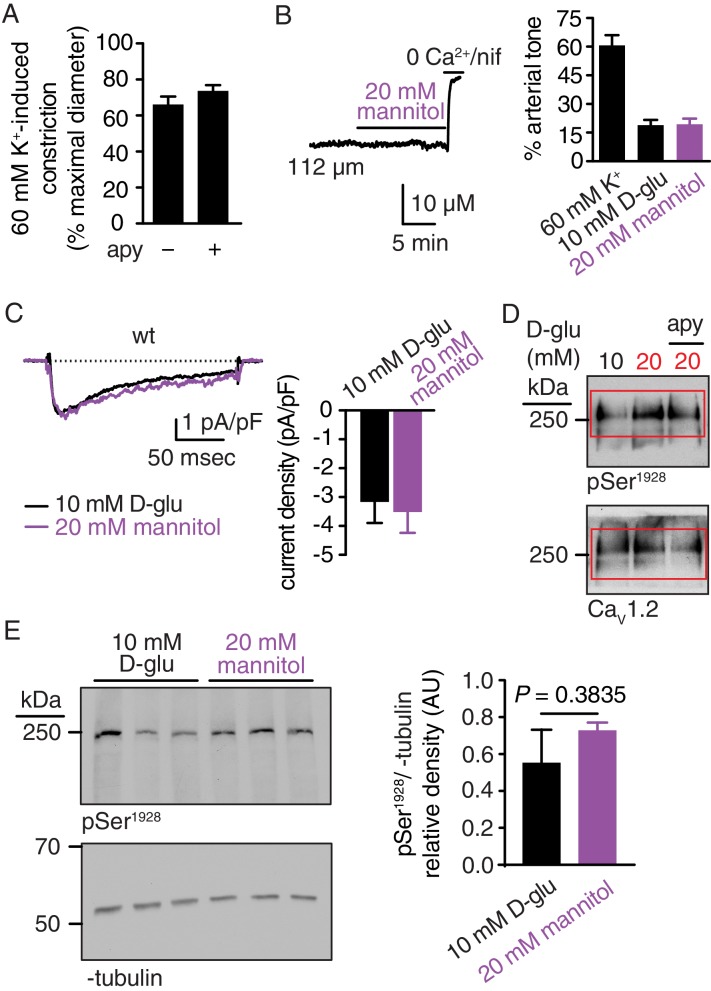
K+-induced arterial constriction in the absence and presence of apyrase, no changes in arterial tone, IBa and pSer1928 in response to 20 mM mannitol, and full-length blots corresponding to Figure 1C.(A) Bar plot of % constriction in response to high K+ (60 mM) from wt mouse cerebral arteries exposed to 10 mM D-glucose in the absence and presence of apyrase (apy; 0.32 U/ml; n = 6 arteries from six mice per condition; Figure 1—figure supplement 1—source data 1). Response to high K+ (60 mM) was obtained in pressurized arteries at 20 mmHg. (B) Representative diameter recording and summary arterial tone data from pressurized (60 mmHg) wt mouse cerebral arteries before and after application of 20 mM mannitol (n = 6 arteries from six mice; Figure 1—figure supplement 1—source data 2). (C) Exemplary IBa recording from the same cell and summary IBa data from wt mouse cerebral arterial myocytes evoked by step depolarizations from −70 to +10 mV before and after application of 20 mM mannitol (n = 7 cells from three mice; Figure 1—figure supplement 1—source data 3). (D) Complete scan of representative phosphorylated Ser1928 (pSer1928) and total CaV1.2 blots for mouse arteries incubated with 10 mM D-glucose, 20 mM D-glucose and 20 mM D-glucose +apyrase. Red boxes indicate the crop region displayed in the main Figure 1C. (E) Representative immunoblot detection of phosphorylated Ser1928 (pSer1928) and α-tubulin (loading control) from wt mouse arteries after 10 min incubation in either 10 mM D-glucose or 20 mM mannitol (n = 5 arterial lysates from five mice per condition) and quantification of pSer1928 (AU = arbitrary units) (*p=0.3835, unpaired t-test; Figure 1—figure supplement 1—source data 4).10.7554/eLife.42214.004Figure 1—figure supplement 1—source data 1.Excel spreadsheet containing the individual numeric values of 60 mM K+-induced % constriction analyzed in Figure 1—figure supplement 1A.10.7554/eLife.42214.005Figure 1—figure supplement 1—source data 2.Excel spreadsheet containing the individual numeric values of % arterial tone analyzed in Figure 1—figure supplement 1B and corresponding raw diameters.10.7554/eLife.42214.006Figure 1—figure supplement 1—source data 3.Excel spreadsheet containing the individual numeric values of current density analyzed in Figure 1—figure supplement 1C.10.7554/eLife.42214.007Figure 1—figure supplement 1—source data 4.Excel spreadsheet containing the individual numeric values of pSer1928/α-tubulin relative density analyzed in Figure 1—figure supplement 1E.